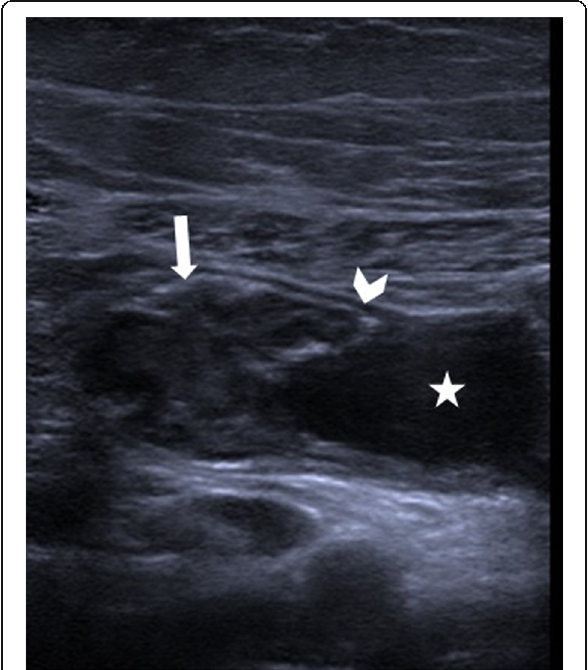
Fig. 28 A 7-year-old female patient presenting to ED with right lower quadrant pain. Axial view US image demonstrates a purely cystic mass (star) in the right lower quadrant. The wall of this lesion was in direct continuity (arrowhead) with the adjacent terminal ileum segment (arrow)